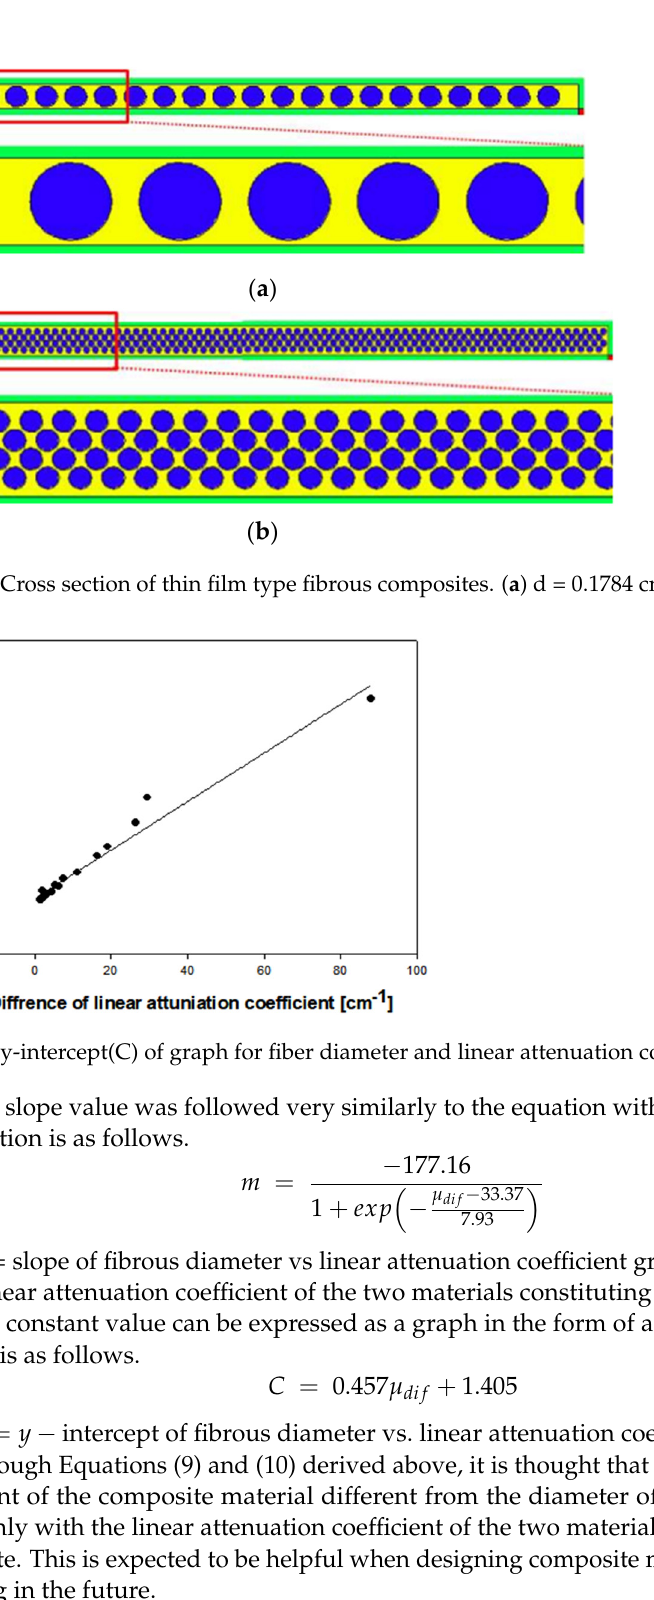
Figure 7. Linear attenuation coefficient of fibrous composite; ( a ) PE/concrete, ( b ) PE/copper, ( c ) PE/lead, ( d ) PE/tungsten.